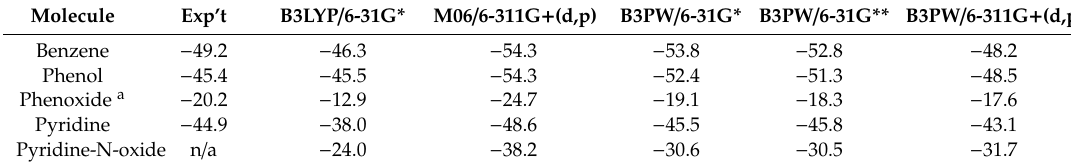
Table 8. Experimental and calculated values (kcal / mol) for saturation with 3 mol of H 2 . Molecule Exp’t B3LYP /